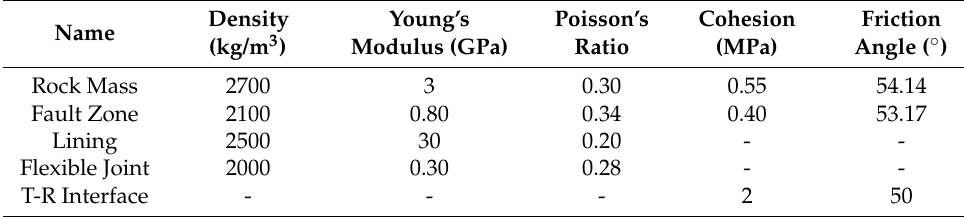
Table 6. Mechanical Parameters of the Numerical Model.